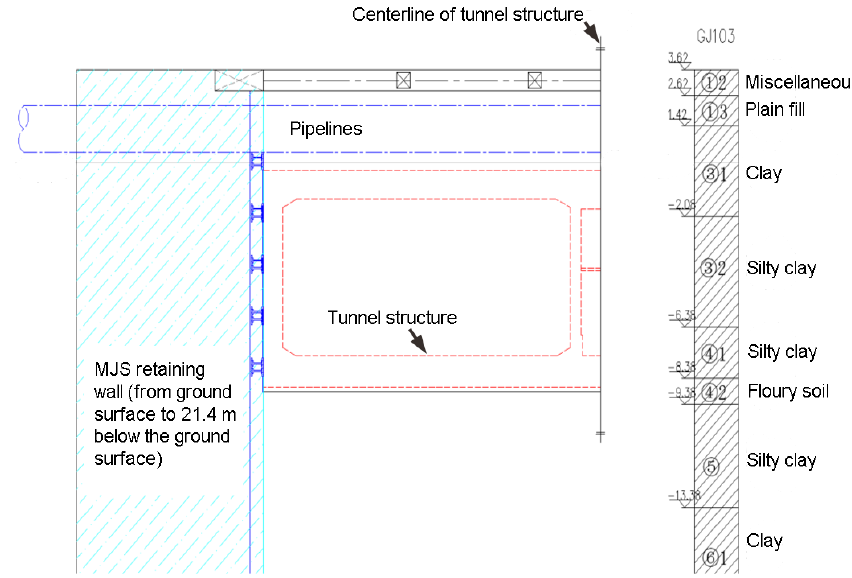
Figure 5. Profile of the soil layers at the site. Table 2. Summary of the thickness and properties of the soil layers.